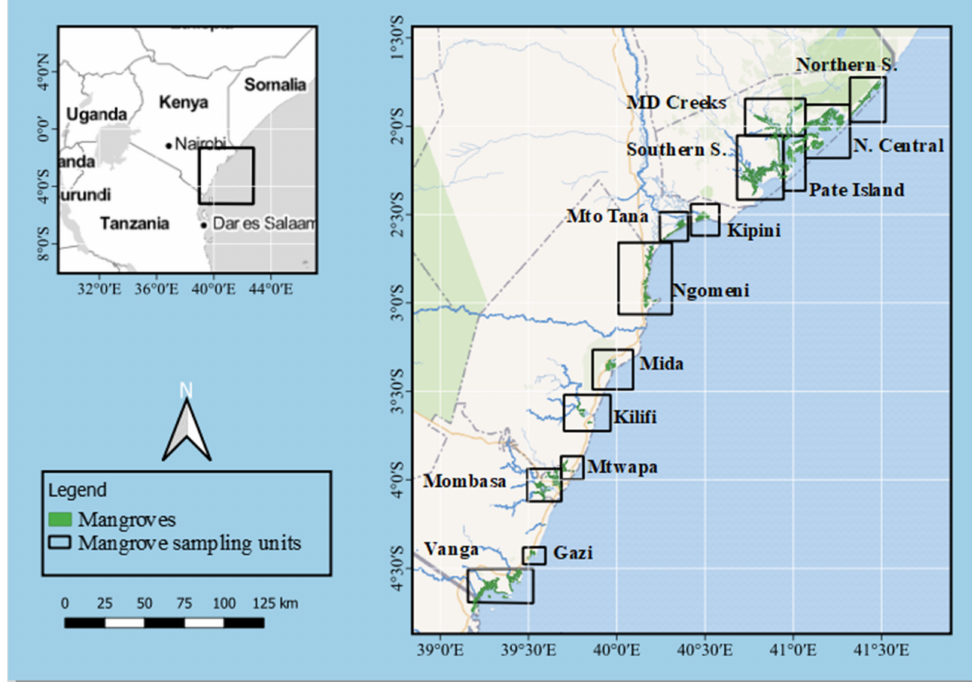
Figure 1. Map of the study area showing mangrove management units in Kenya. Northern S denotes Northern Swamps; N. Central—Northern Central Swamps; MD Creeks—Mongoni Dodori Creek Swamps; Southern S—Southern